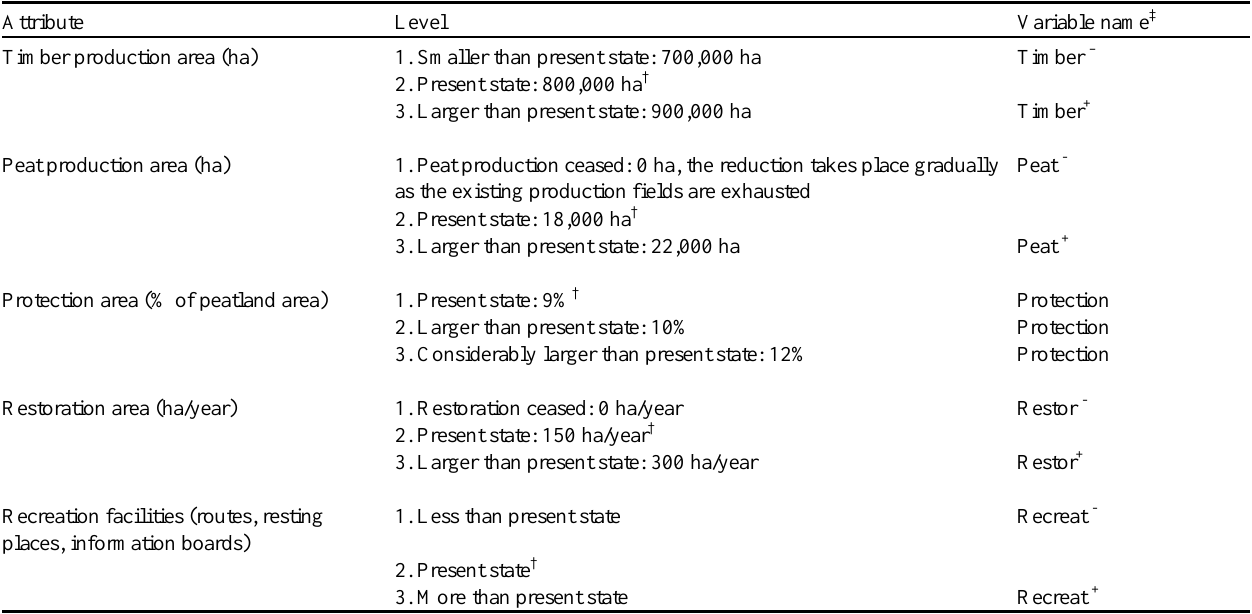
Table 1 . Attributes (peatland use options) and their levels in the choice tasks with variable names used in the analysis. Attribute